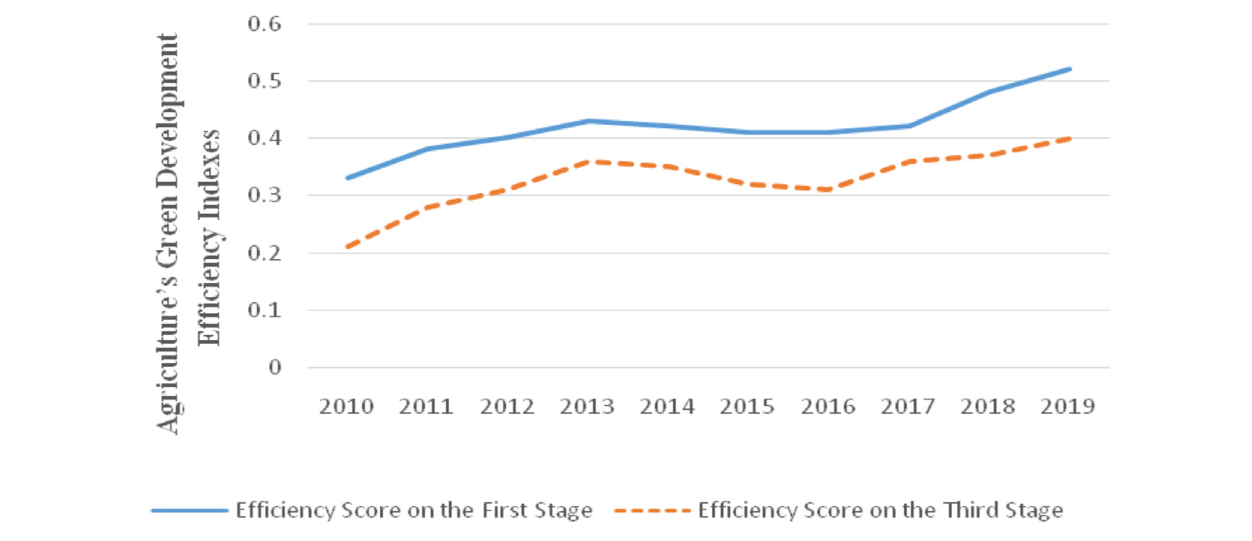
FIGURE 3 | Indexes of Chinese agricultural green development ef fi ciency from 2010 to 2019.